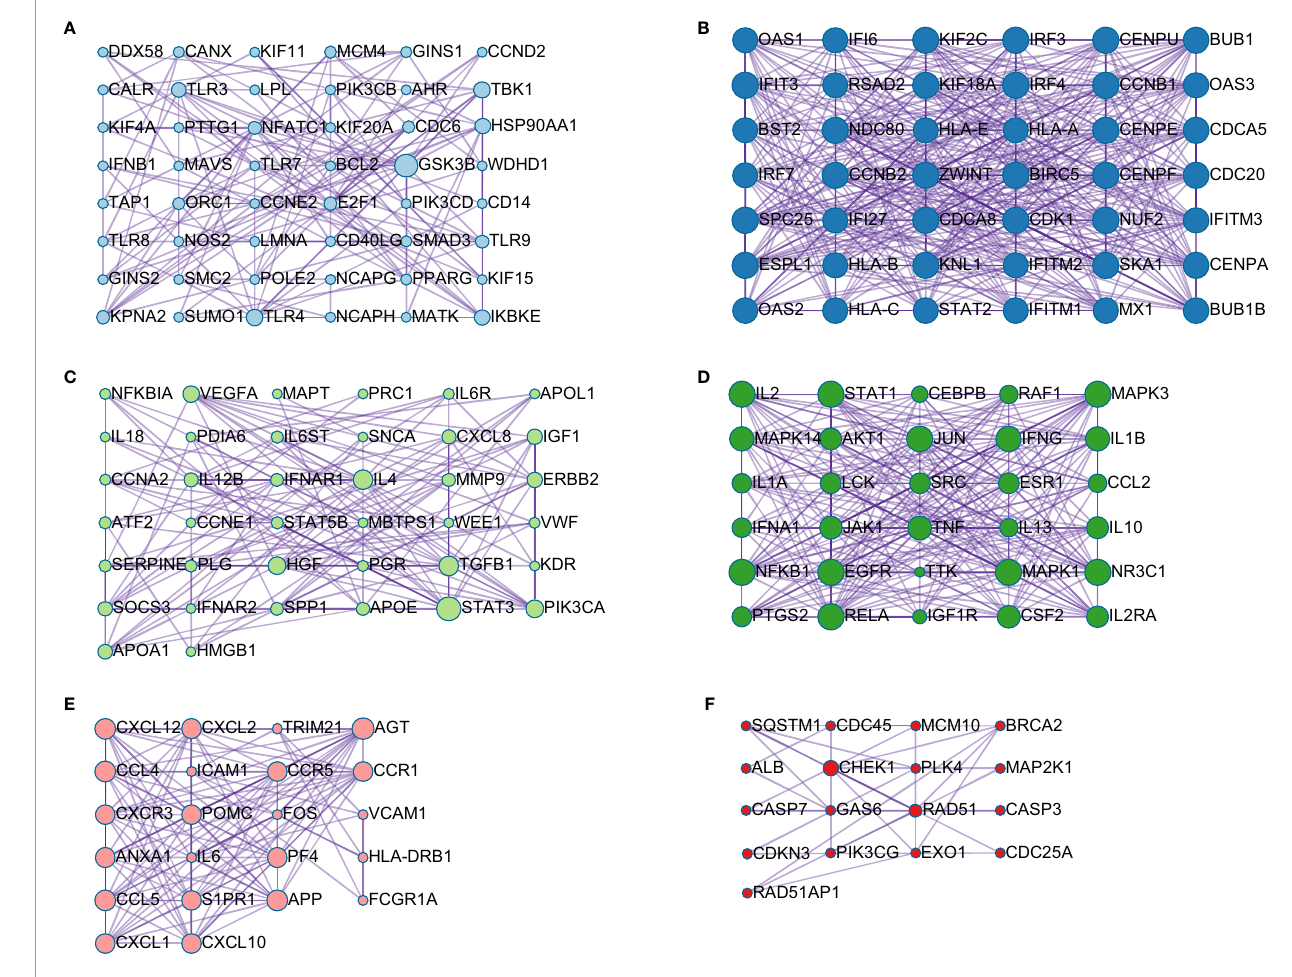
FIGURE 3 | Module analysis of the 460 shared genes. Each module demonstrates different biological process functions. (A) module 1; (B) module 2; (C) module 3; (D) module 4; (E) module 5; (F) module